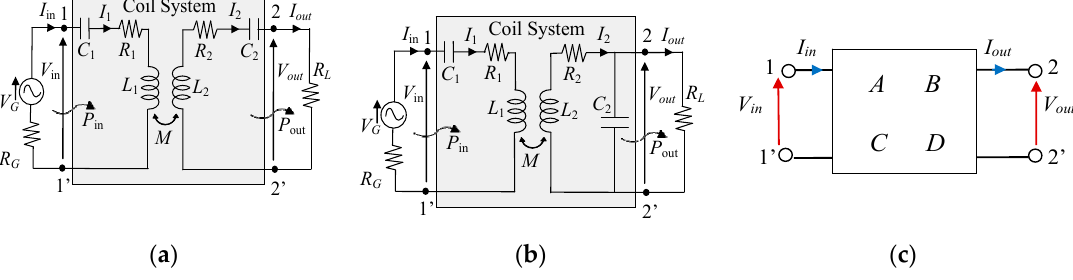
Figure 10. Equivalent circuits for series-series (SS) ( a ) and series-parallel (SP) ( b ) compensation